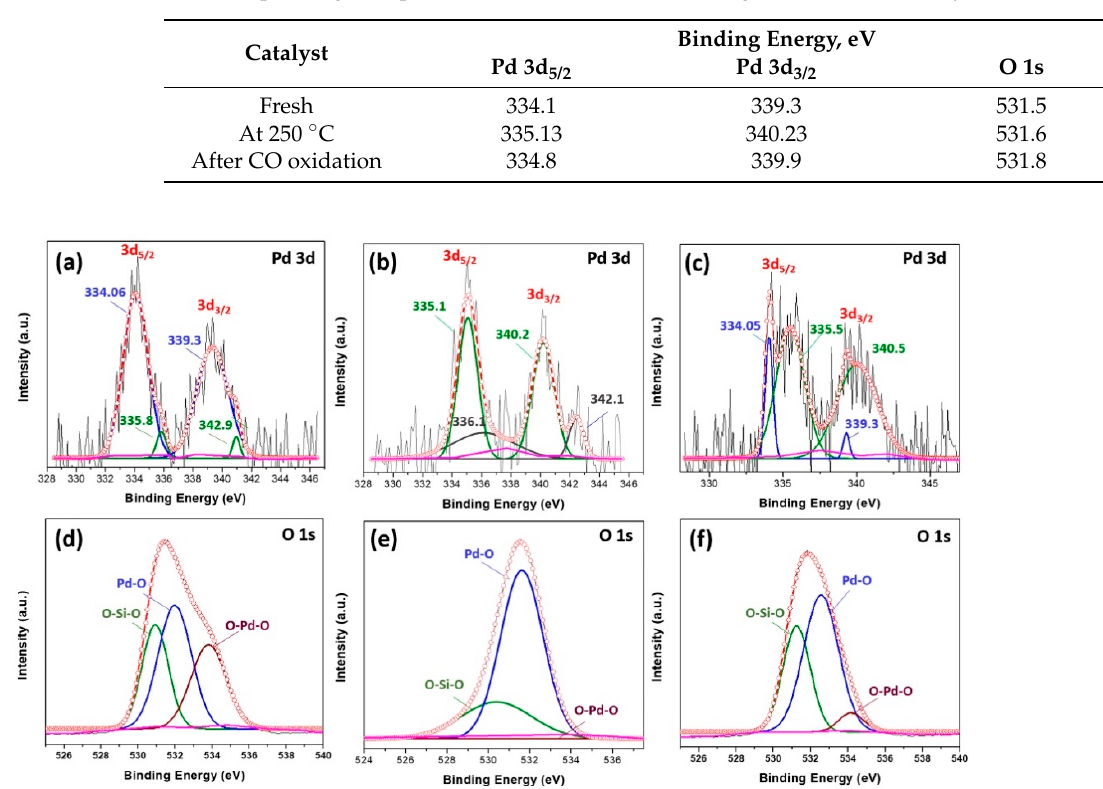
Figure 3. High-resolution XPS spectra of Pd 3d of ( a ) fresh Pd/SiO 2 catalysts, ( b ) Pd/SiO 2 catalysts annealed at 250 °C (full CO conversion), and ( c ) Pd/SiO 2 catalysts after the heating/cooling cycle in the CO/O 2 reaction mixture, and the deconvolution of O 1s XPS spectrum: ( d ) Before CO oxidation, ( e ) at 250 °C, and ( f ) after CO oxidation.